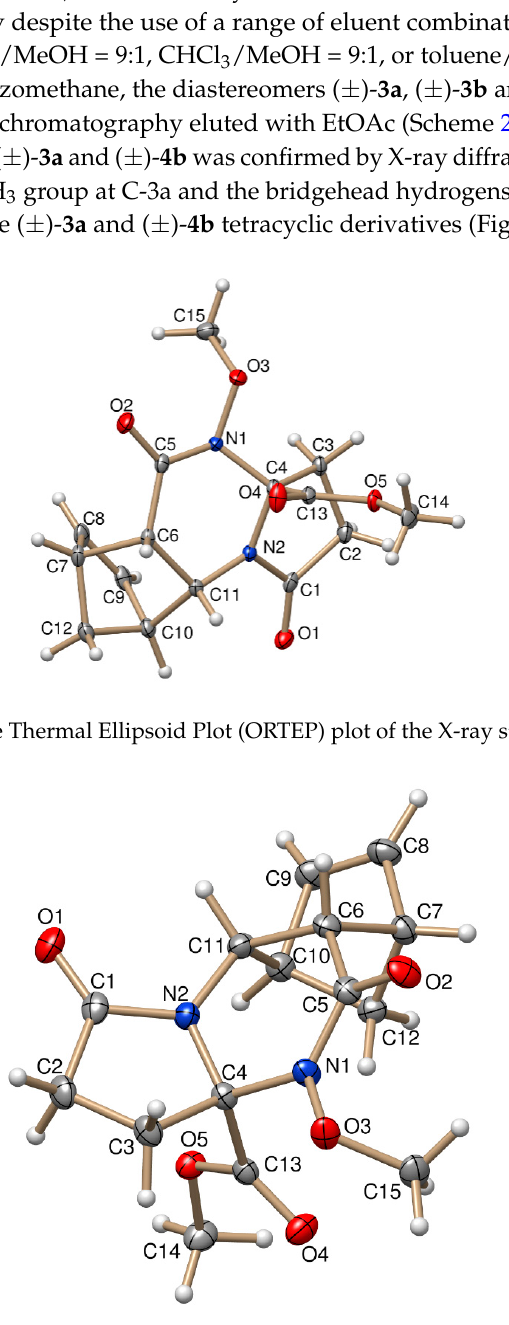
Figure 2. ORTEP plot of the X-ray structure of (±)- 4b .